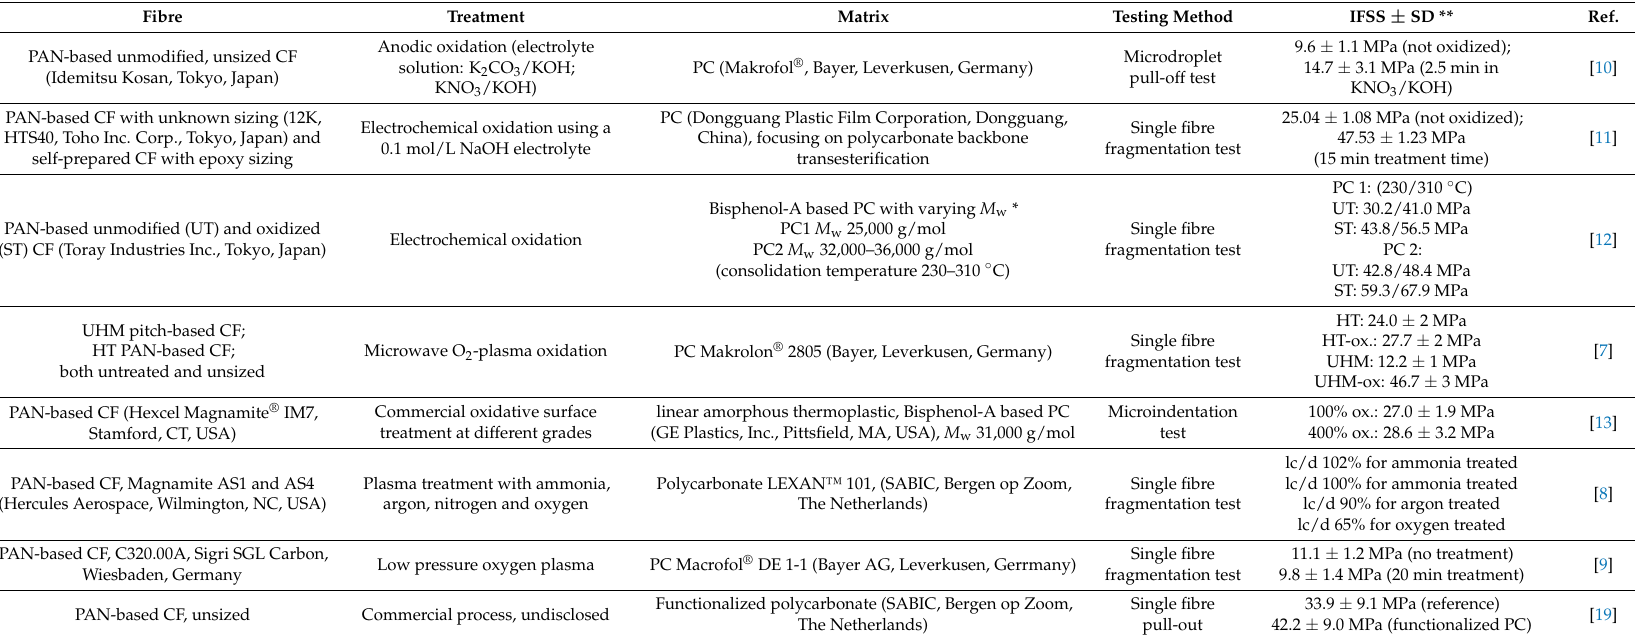
Table 1. Overview of the material modifications, processing conditions, and micromechanical tests applied on carbon fibre—polycarbonate composites to increase and characterize the fibre-matrix adhesion by the interfacial shear strength (IFSS; the results represent the lowest and highest achieved value of the investigated materials for each reference); * M w = molecular weight, ** SD = standard